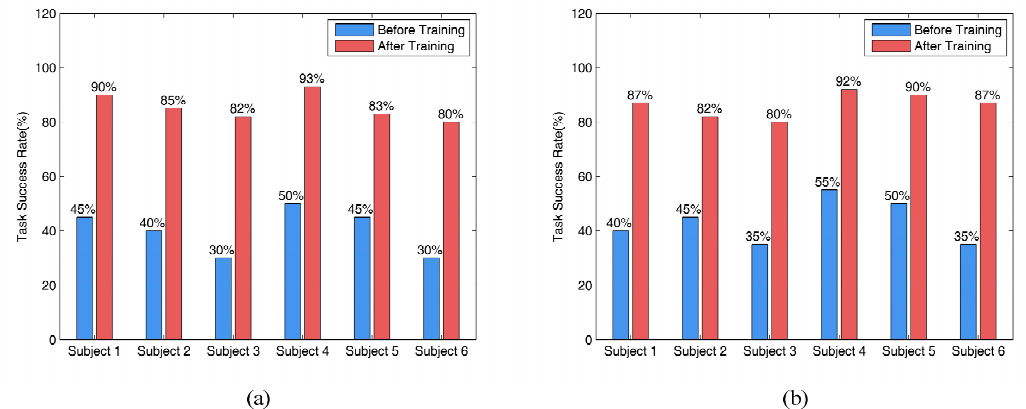
Figure 9. Task success rate of one-dimensional cursor control training. ( a ) Left vs. right. ( b ) Up vs. down.